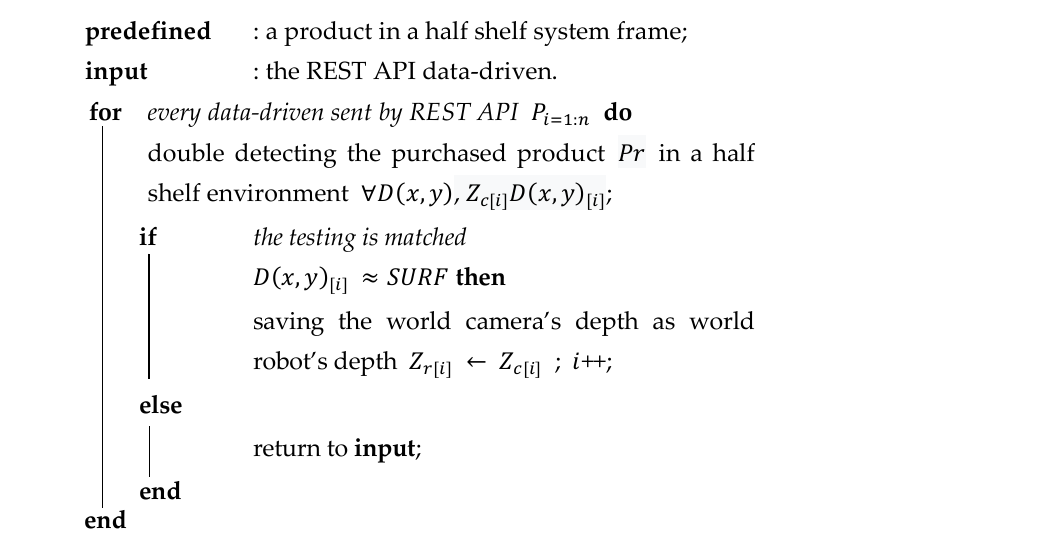
Figure 9. ( a ) Red-cyan composite view of the rectified stereo pair image, ( b ) block matching dis- parity map from ( a ), ( c ) confidence levels of original YOLOv2, ( d ) merger of left and right image with n=10 matching points, and ( e ) output selected detector of modified YOLOv2 with confidence level with XYZ coordinates.